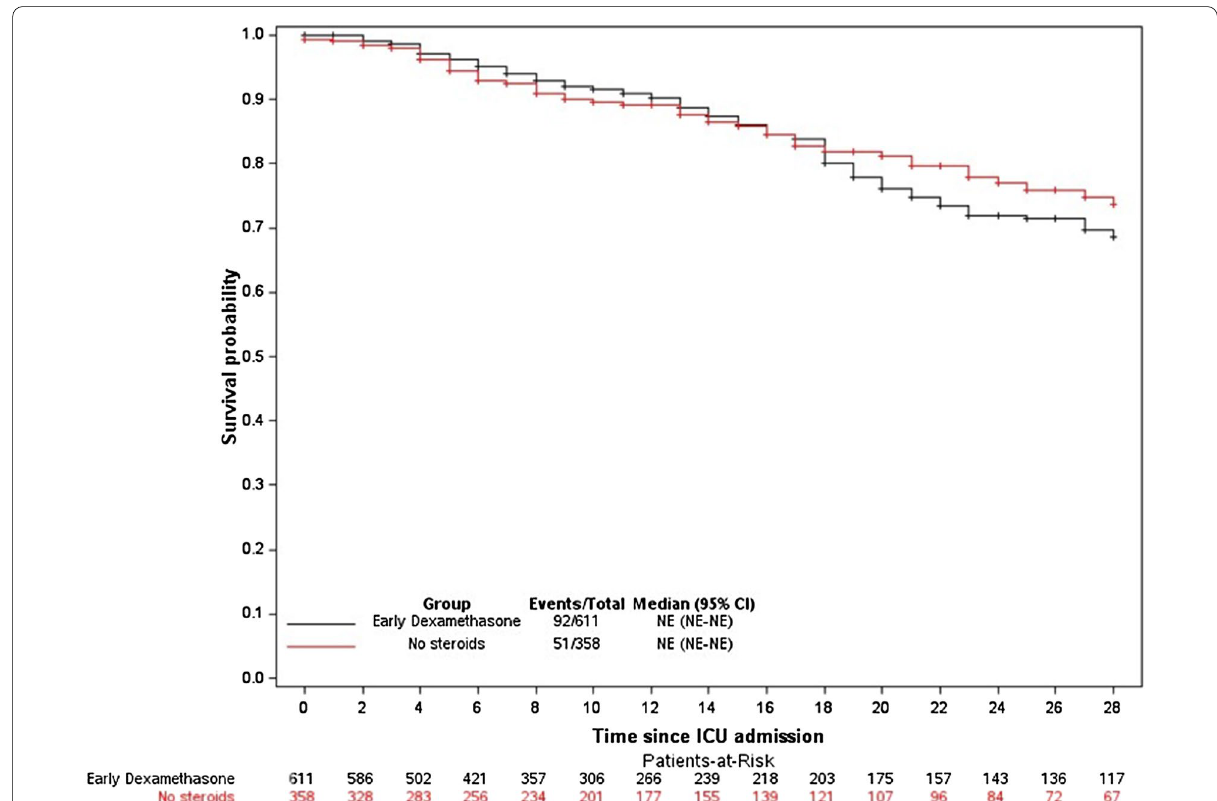
Fig. 2 Day‑28 mortality in the groups with early dexamethasone therapy vs. without any steroids. Survival curves were compared using Cox